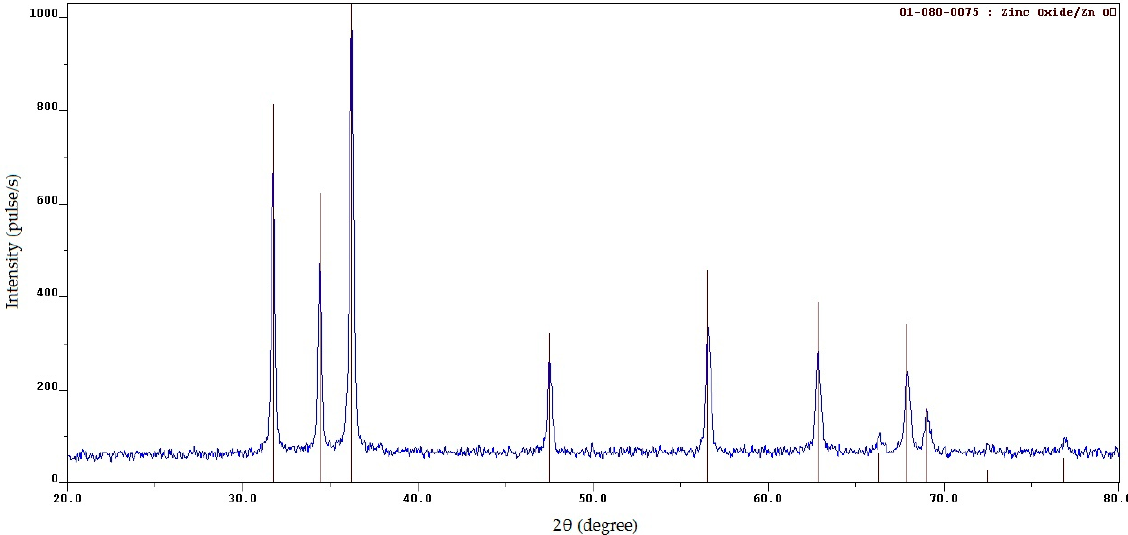
Figure 6. XRD patterns of the SCS product at φ = 3 after calcination.